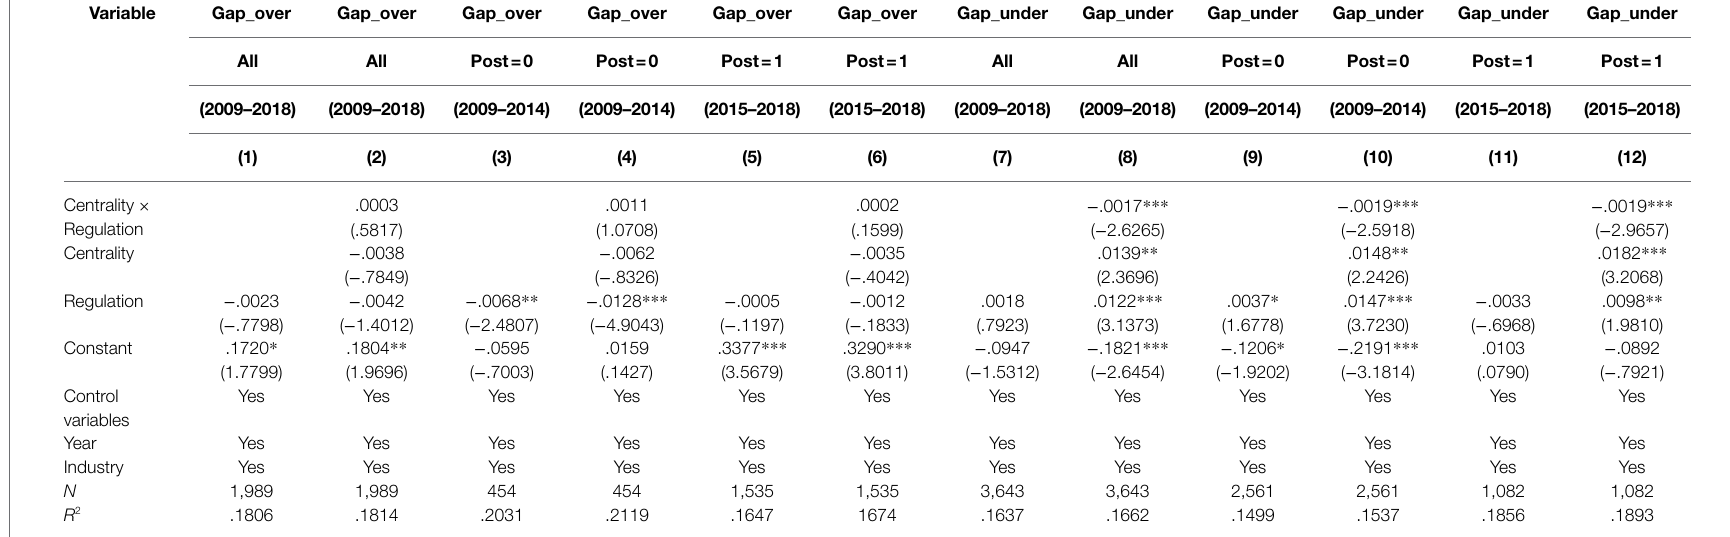
TABLE 8 | Heterogeneity test of environmental regulation.